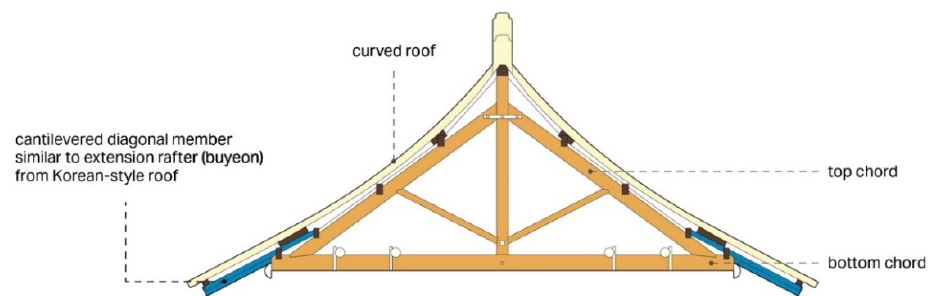
Figure 8. Western Queen Truss (Chungang High School, 1917).